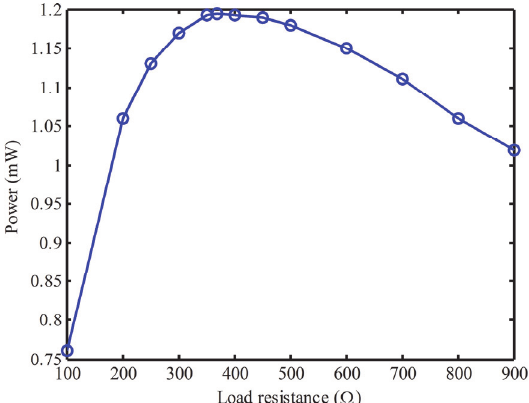
Figure 9. Output power with different load resistances for the MEMEH.